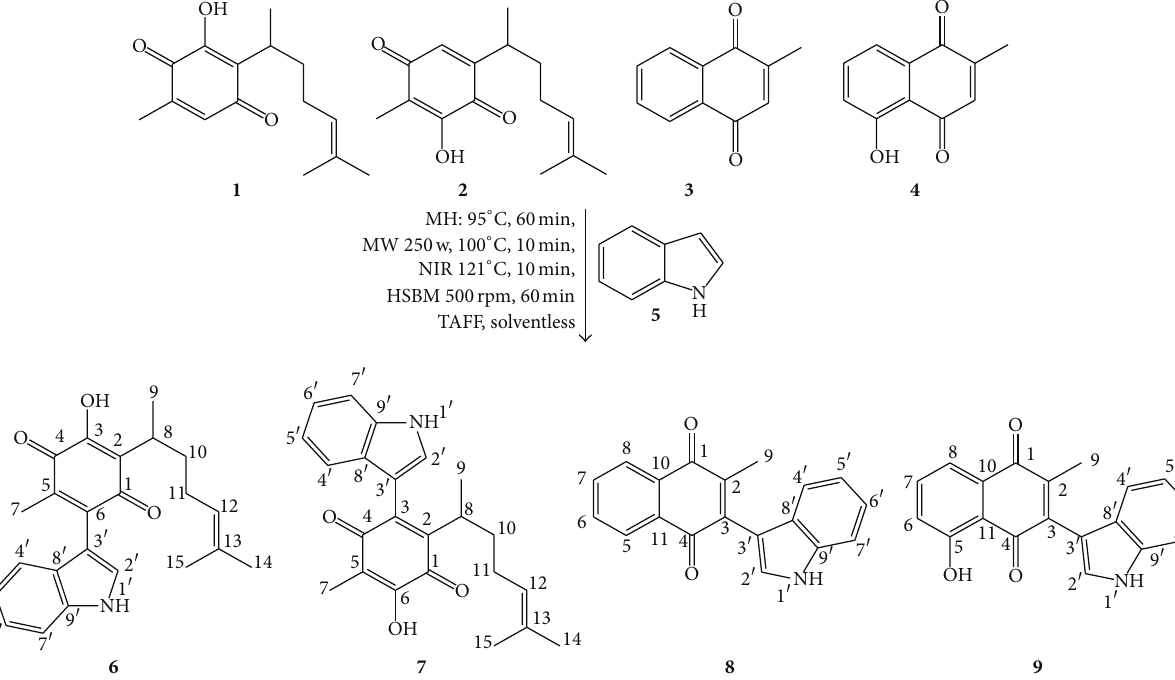
Scheme 1: Synthesis of indole-quinone derivatives.